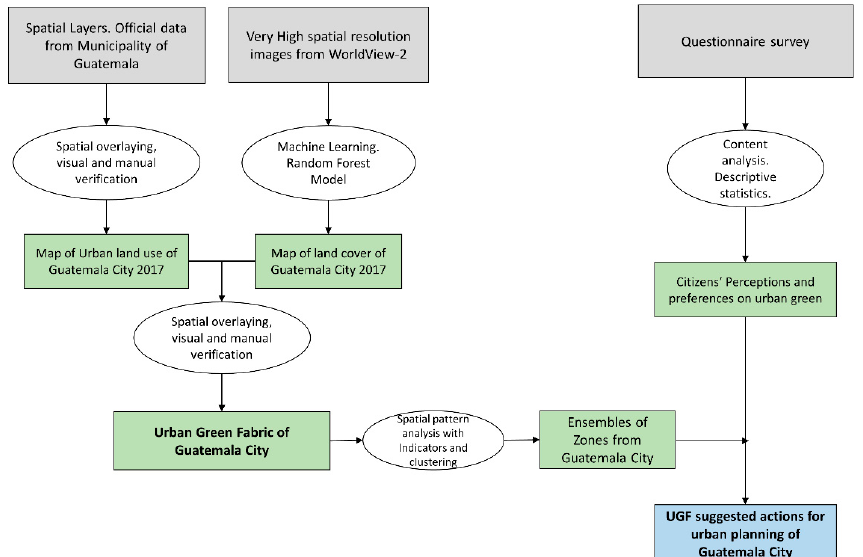
Figure 2. Analysis of Urban Green Fabric (UGF) in Guatemala City Methodological approach. Gray boxes represent initial information and data. White ovals show methods and techniques used for analysis. Green boxes, results and Blue box the discussed actions to inform urban planning in Guatemala City.